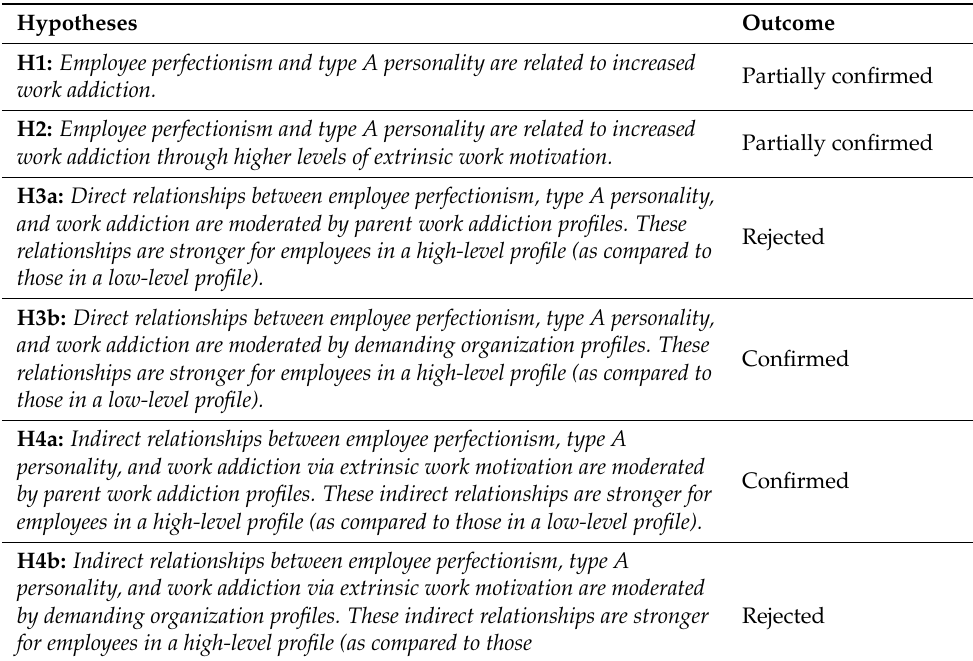
Table 6. Summary of hypothesis